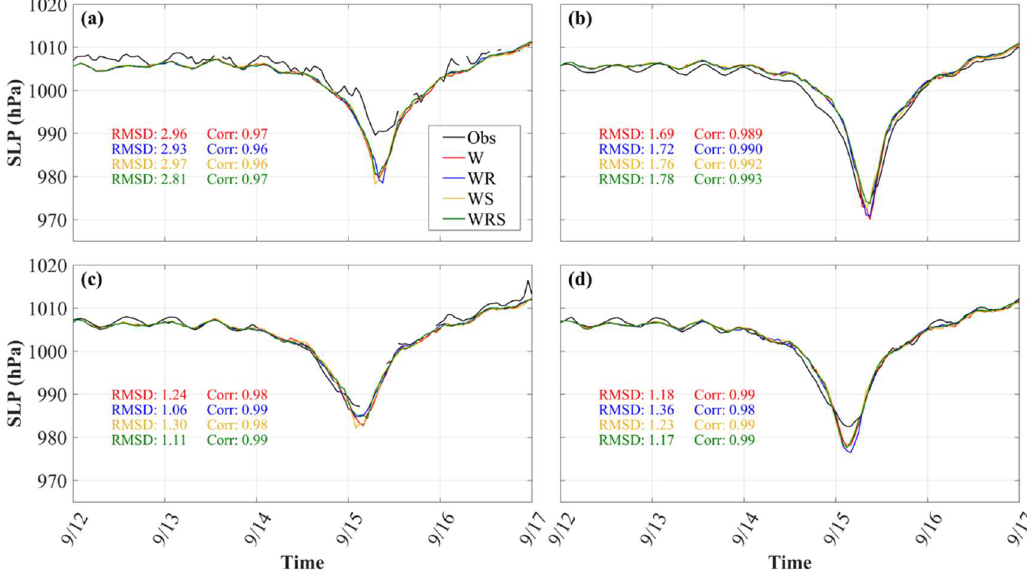
Figure 5. Comparison of observed and simulated sea level pressure (hPa). ( a ) Buoy 1; ( b ) Buoy 2; ( c ) Buoy 4; and ( d ) Buoy 5. Observation (black), W (red), WR (blue), WS (orange) and WRS (green). The same colors are used for RMSD and R 2 , which are calculated relative to observations.